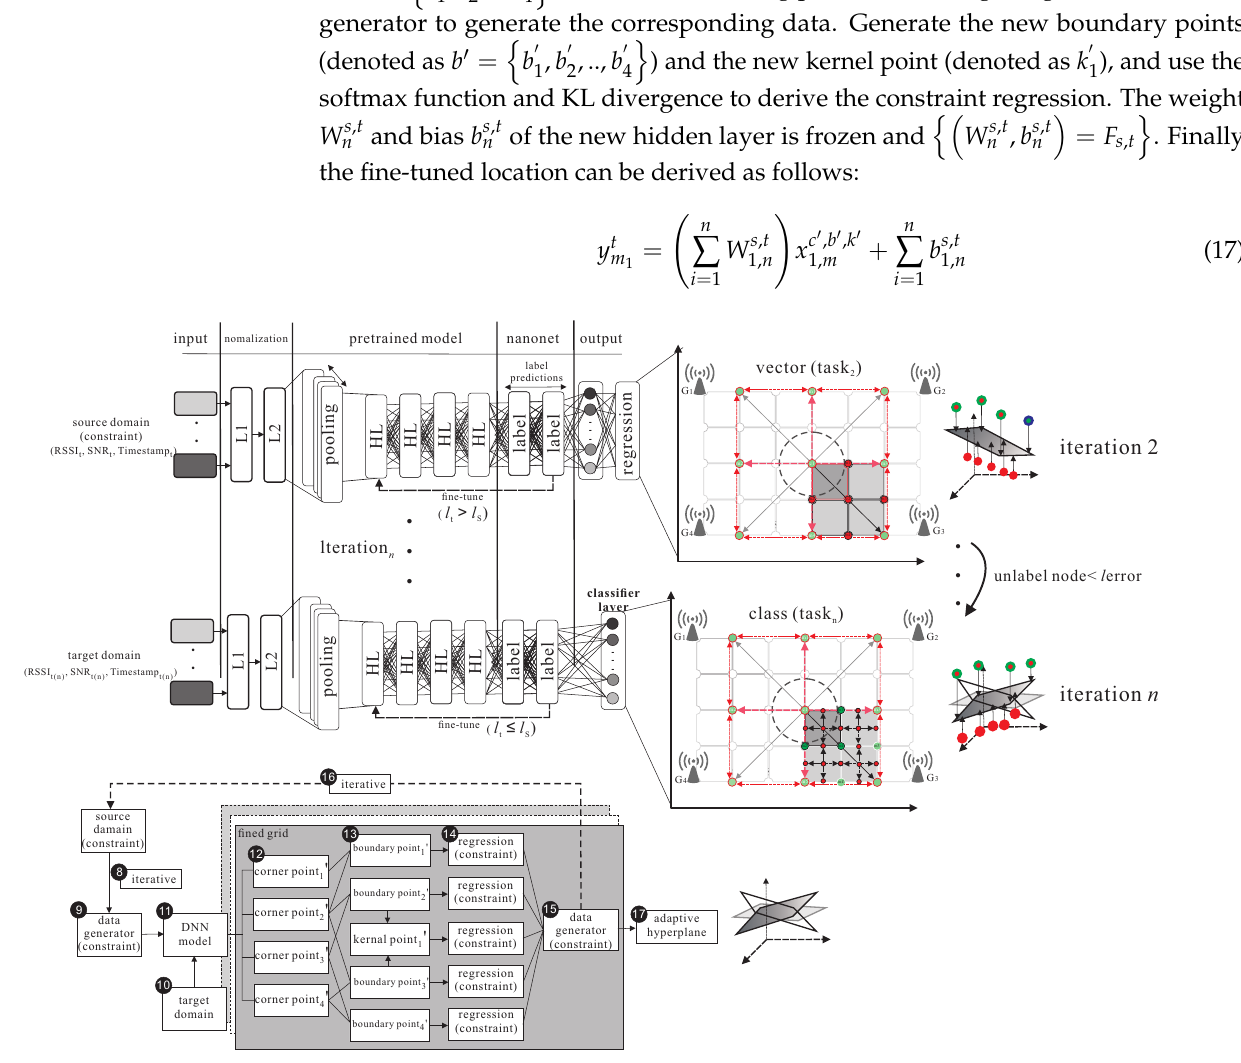
Figure 10. The grid segmentation fine-tuning